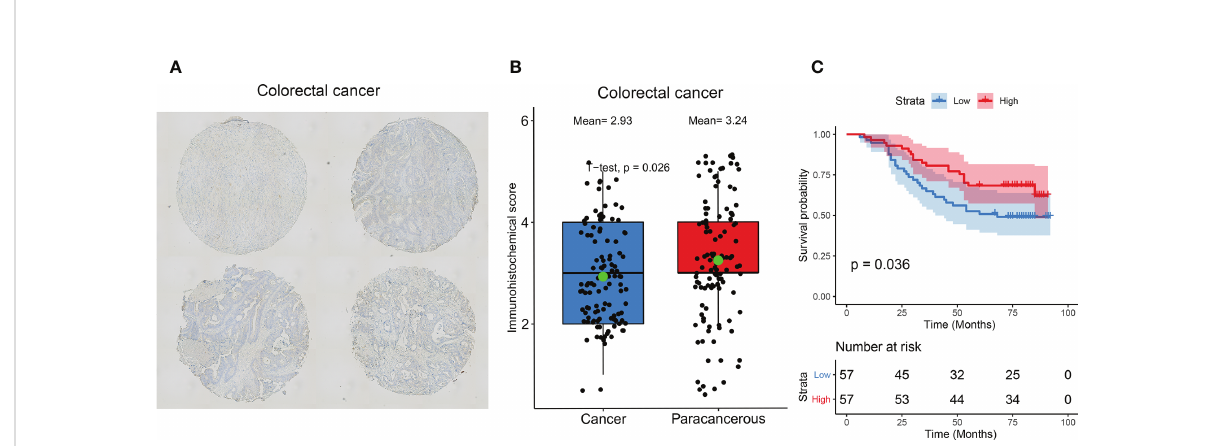
FIGURE 5 Immunohistochemical validation of AIM2 expression and prognosis. (A) Representative images of immunohistochemical detection of AIM2 expression in colorectal cancer. (B) Statistical results of AIM2 expression. (Green point represents mean values; Student ’ s t-test) (C) Survival analysis of AIM2. Patients were divided into high and low expression groups based on AIM2 expression (Log-rank